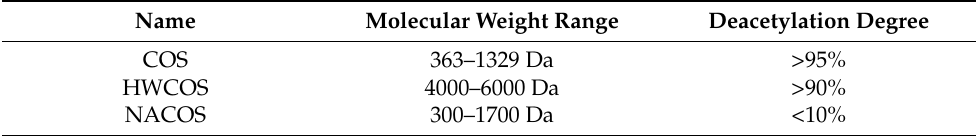
Table 1. The molecular weight range and deacetylation degree of COS, HWCOS, and